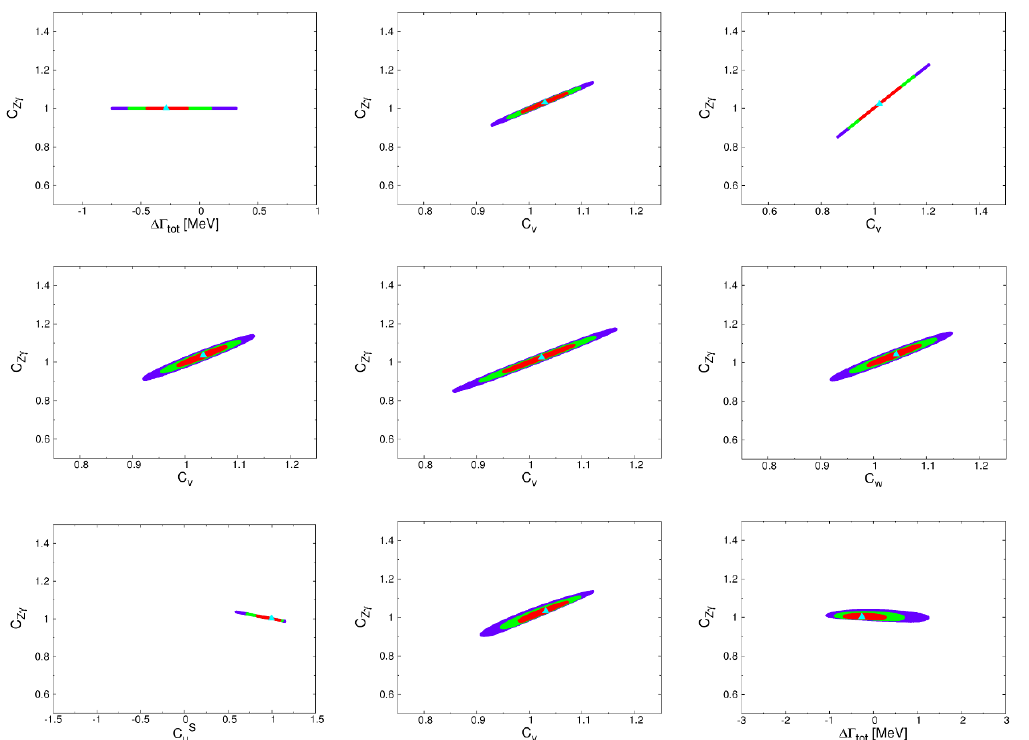
Figure 16 . Predictions for C Z(cid:13) for the scenarios in which (cid:1) S (cid:13) = 0. [Upper]: CPC1 (left), CPCN2 (middle), CPCX2 (right); [Middle]: CPCX3 (left), CPC4 (middle), CPCX4 (right); [Low]: CPV2 (left), CPV3 (middle), CPVN3 (right). The color code is the same as in (cid:12)gure 2 except CPC1 for which (cid:1) (cid:31) 2 (cid:20) 1 (red), 4 (green), and 9 (blue) above the